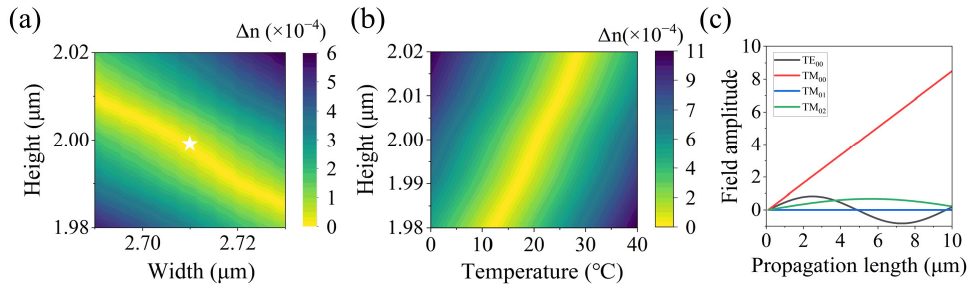
Figure 2. ( a ) The simulated effective refractive index difference ( ∆ n ) between the TE 00 mode of FW and the TM 00 mode of SHW as a function of waveguide geometry at 20 ◦ C. ( b ) The simulated effective refractive index difference as a function of waveguide height and the temperature. ( c ) Calculated field amplitude of SH modes as a function of the propagation length.